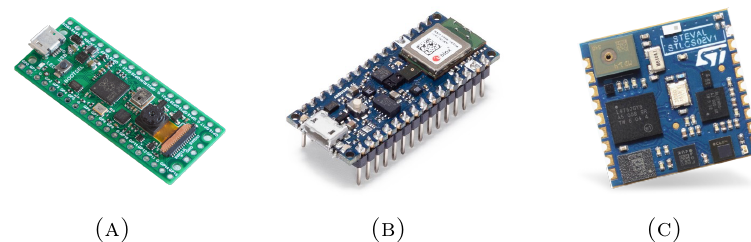
Figure 3. Example TinyML devices: (a) Pico4ML, (b) Arduino Nano 33 BLE Sense, and (c) STMicroelectronics Sensor Tile. These and many other embedded devices are